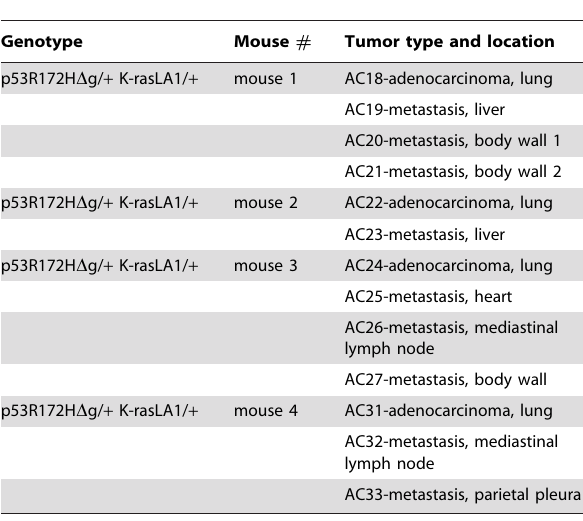
Table 1. Tumors Used for Gene Expression